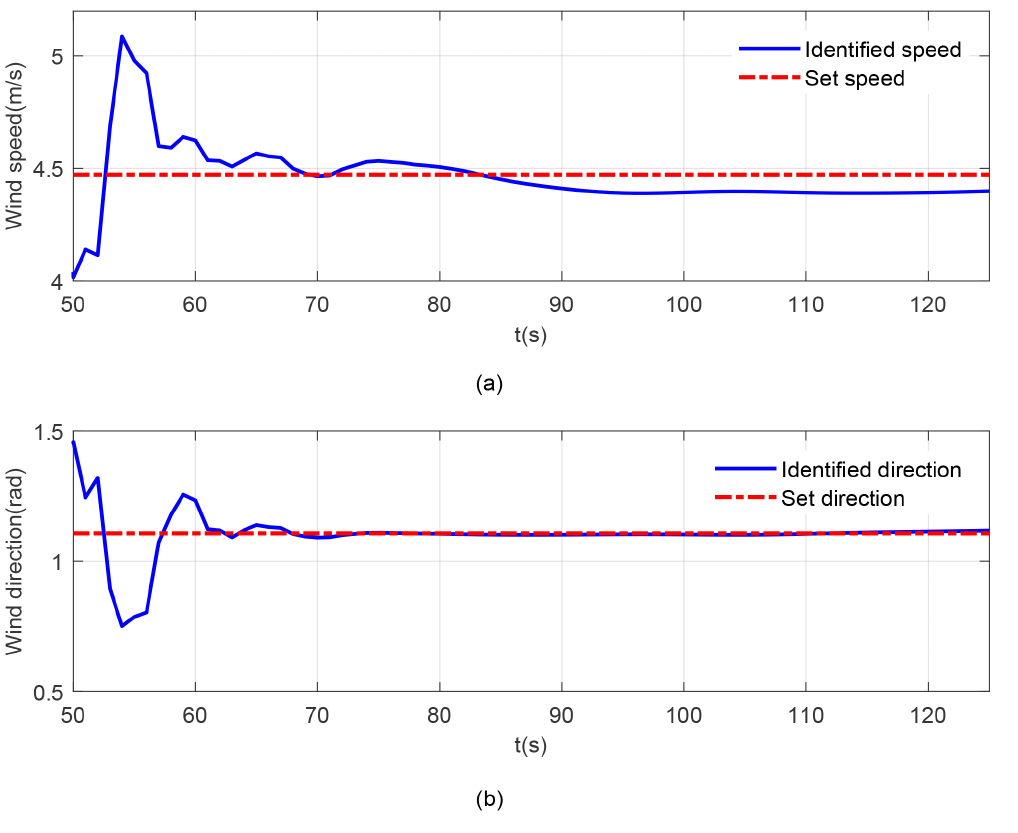
Figure 8. Wind field identification results. ( a ) Wind speed. ( b ) Wind